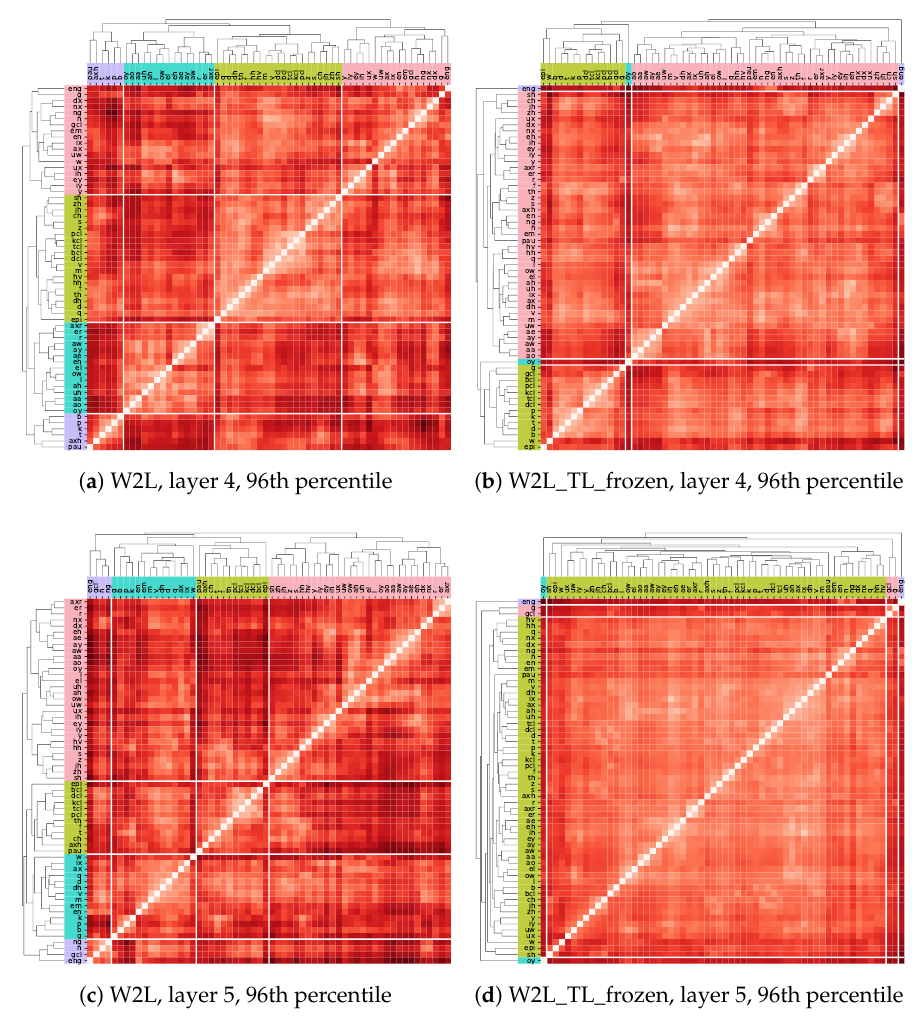
Figure 6. Clustermaps for W2L ( a , c ) and W2L_TL_frozen ( b , d ) in layer 4 ( a , b ) and 5 ( c , d ) at the percentile with highest change of Silhouette score from layer 4 to layer 5. Heat map colors do not represent same distance values in different plots. Colors of clusters in different subfigures do not represent mapping of the clusters. See Figure 7 for an enlarged clustering